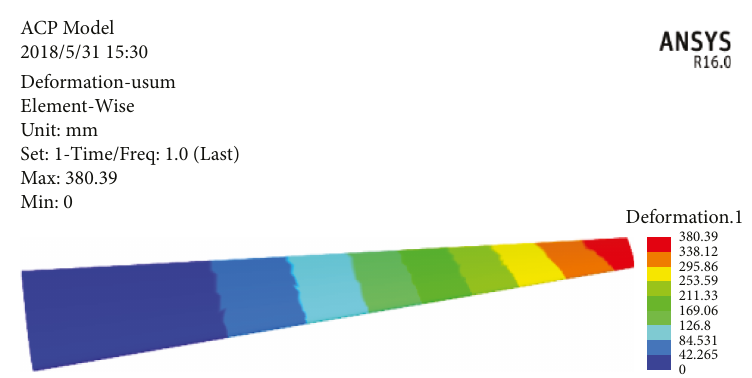
Figure 50: Deformation cloud diagram with the layer ratio being